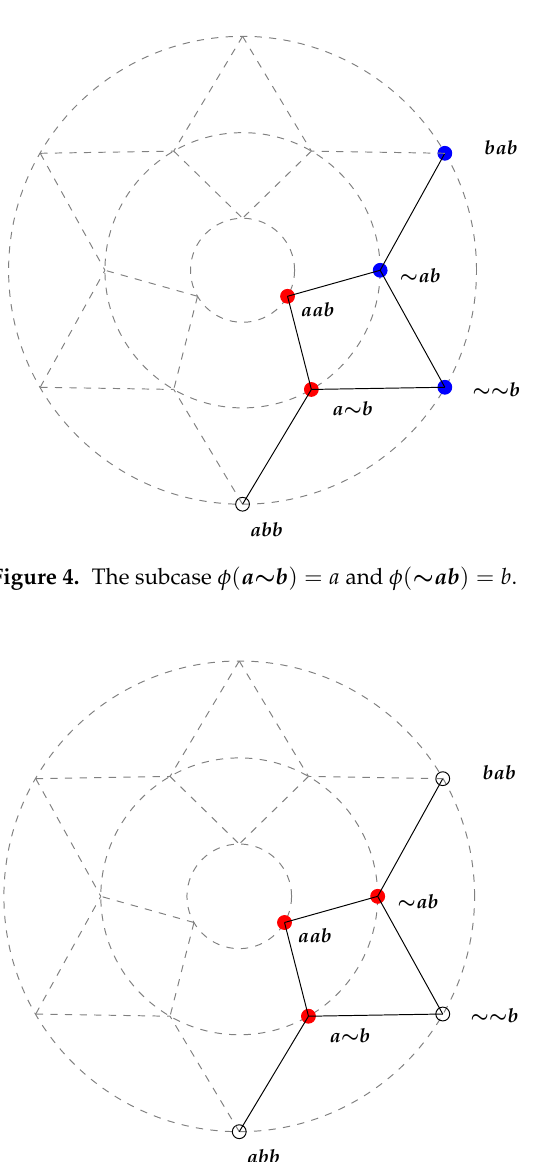
Figure 5. The subcase φ ( a